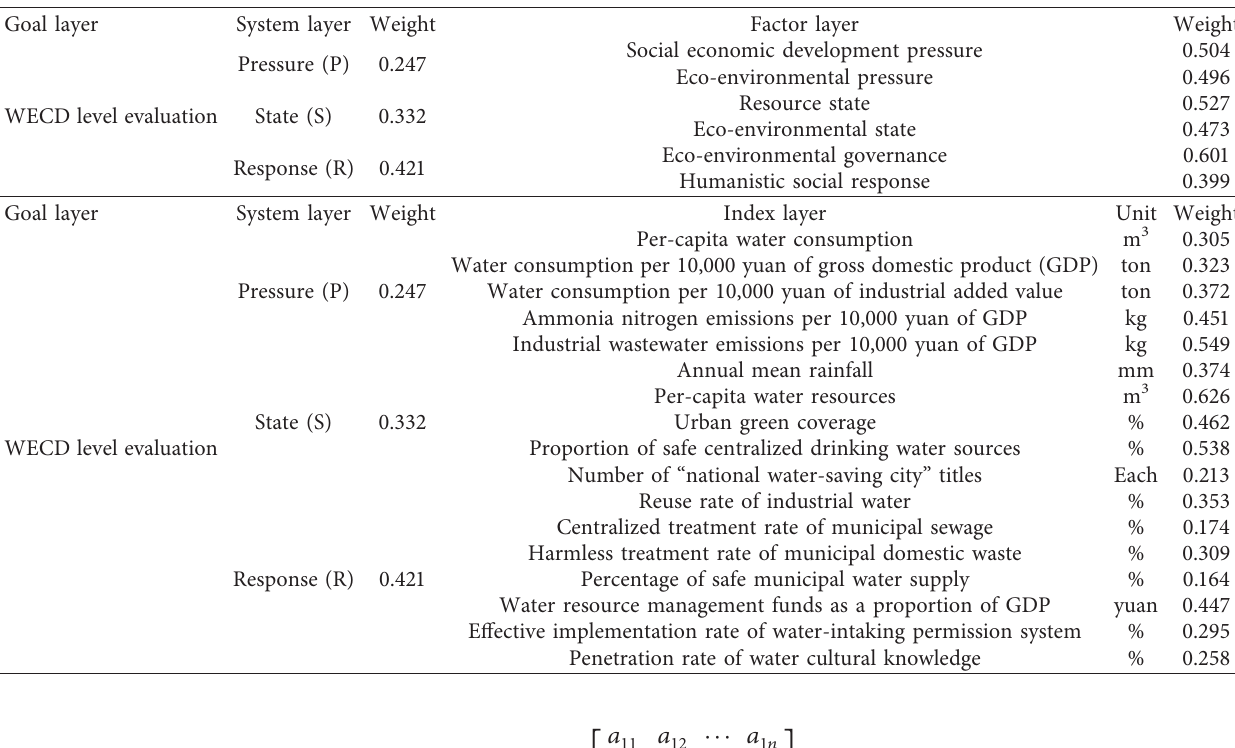
Table 1: EIS for YREB WECD